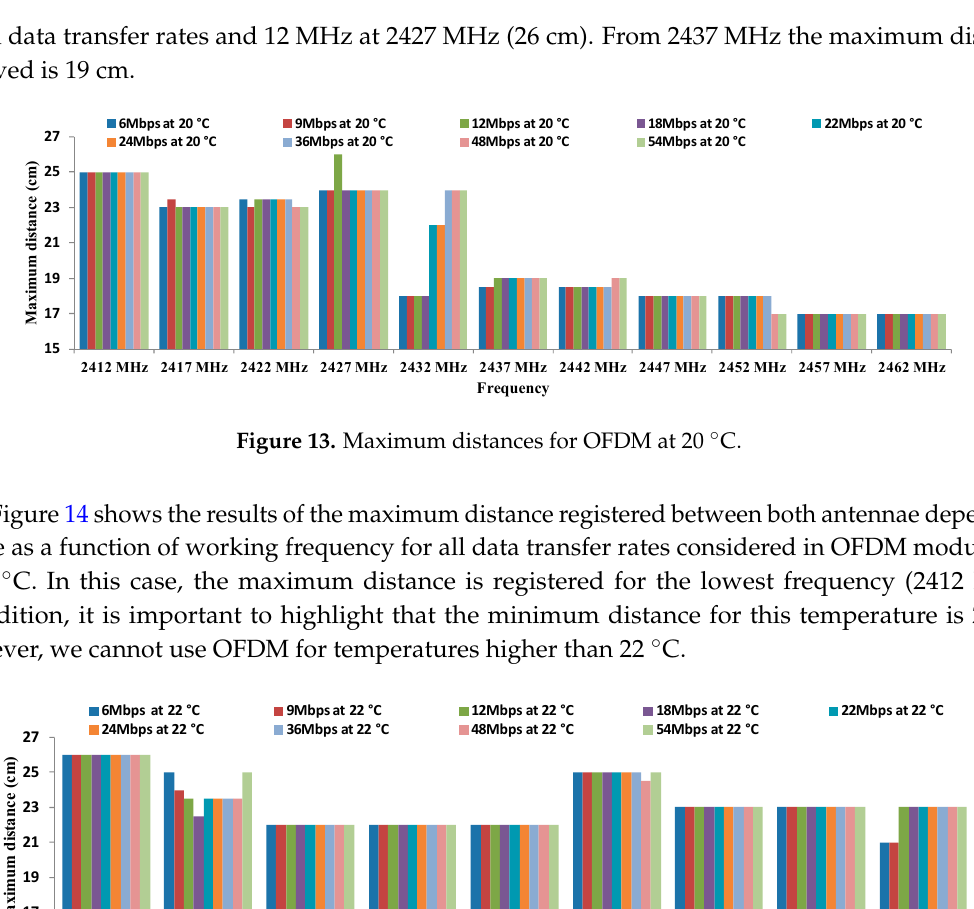
Figure 12. Maximum distances for OFDM at 18 °C.